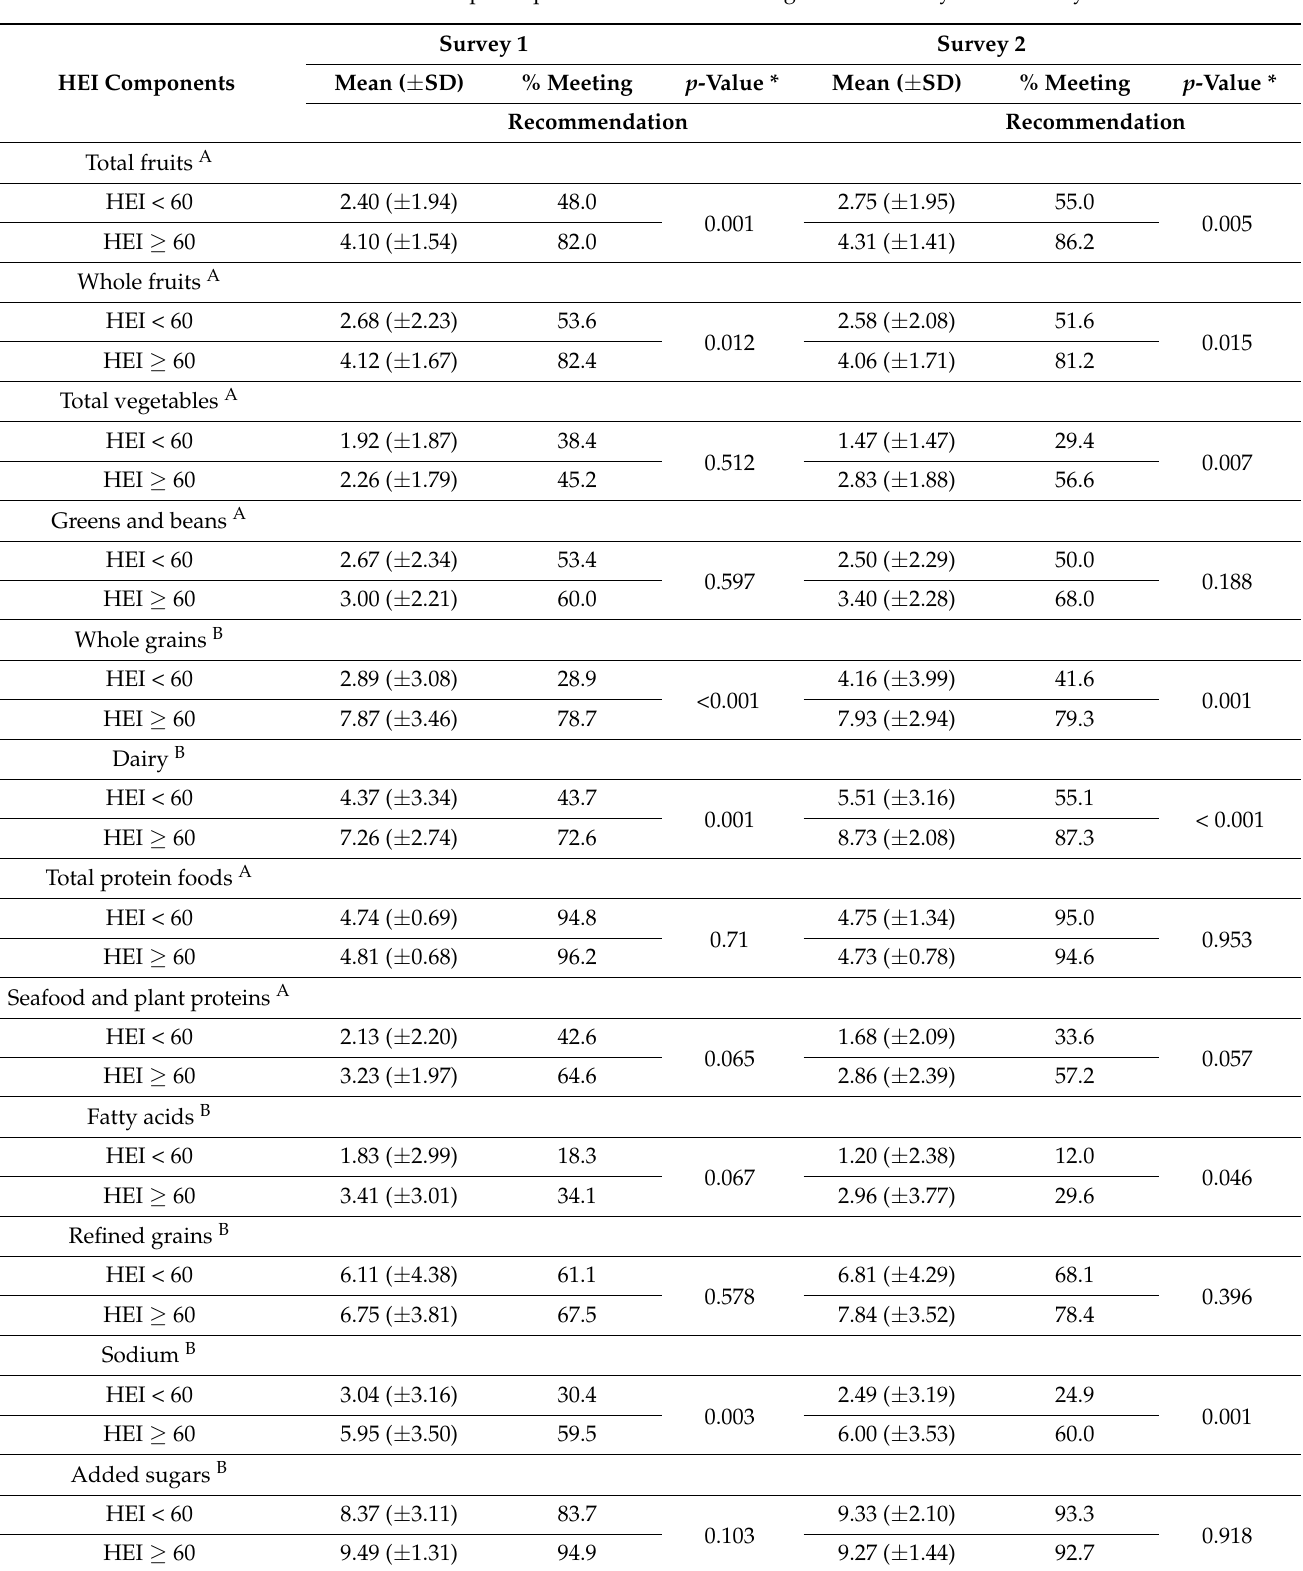
Table 3. Mean HEI scores of participants in the two HEI categories for survey 1 and survey